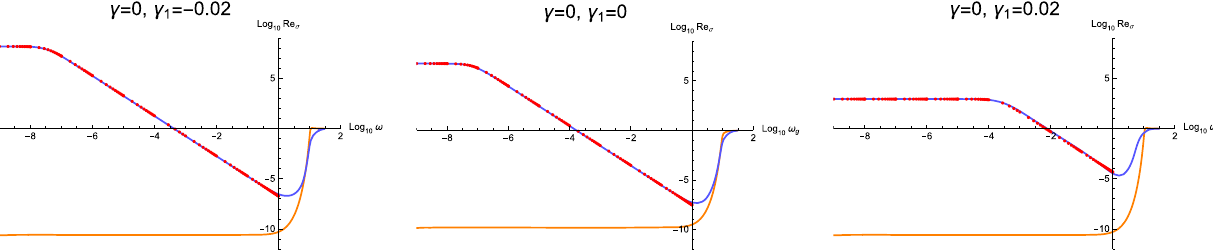
Fig. 7 Logarithmic real parts of conductivity versus the logarithmic frequencies in 6 derivative theory with different coupling parameter γ 1 . The blue line is σ xx while the orange line for σ yy . The red points are the fitting of σ xx for various γ 1 in the low frequency limit